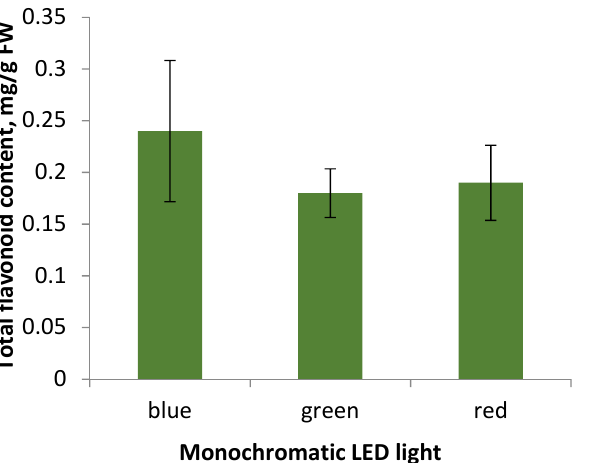
Figure 6. Total flavonoid content in callus tissue of the 5th subculture under different light conditions of cultivation.